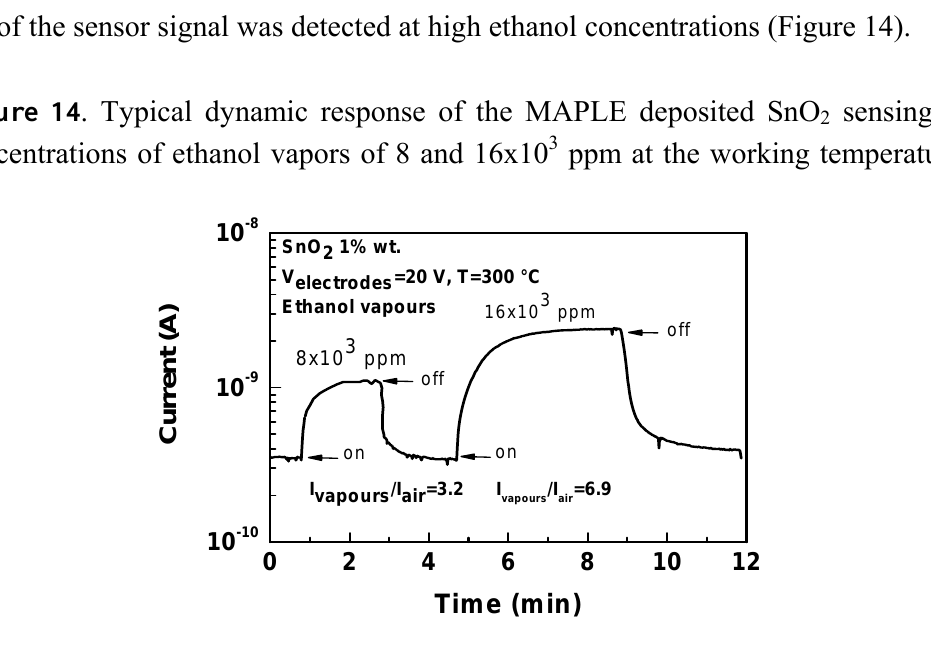
sensing layer for 2